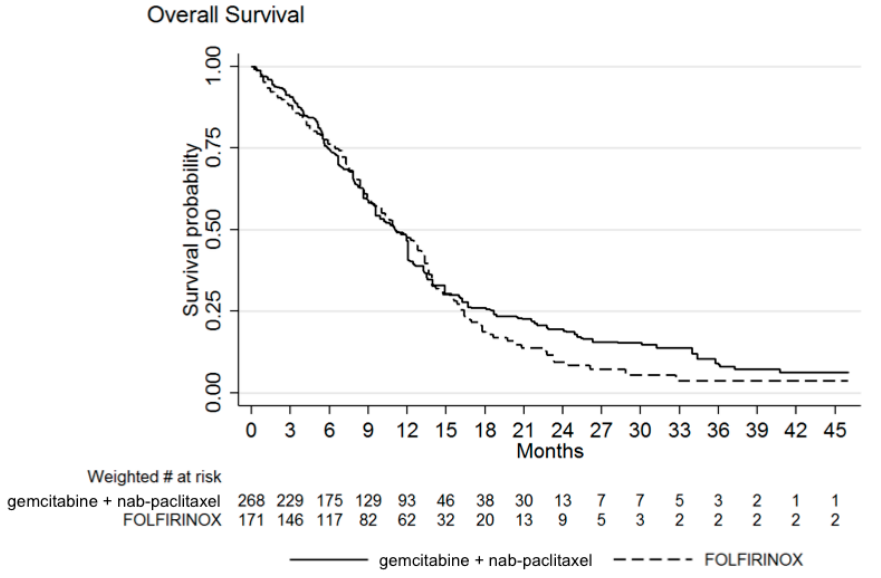
Figure 1. Weighted Kaplan–Meier estimates of overall survival (OS). Median OS was 11.1 months with both treatments. Hazard ratio of FOLFIRINOX over gemcitabine + nab-paclitaxel was 1.10 (95% confidence interval, CI 0.81–1.49; p = 0.527).